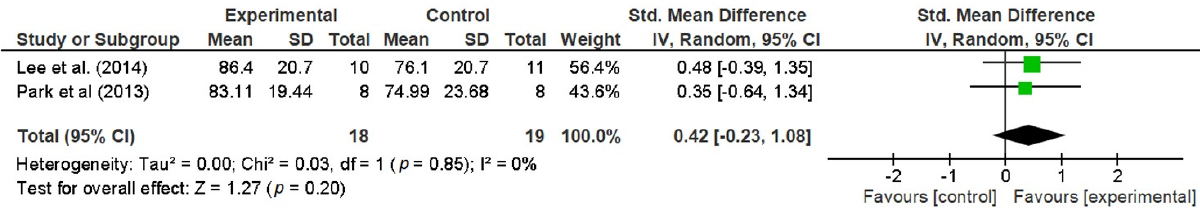
Figure 9. Pooled standardized mean differences and overall effect size (95% CI) on the stride length (paretic side) imme- diately after the intervention.